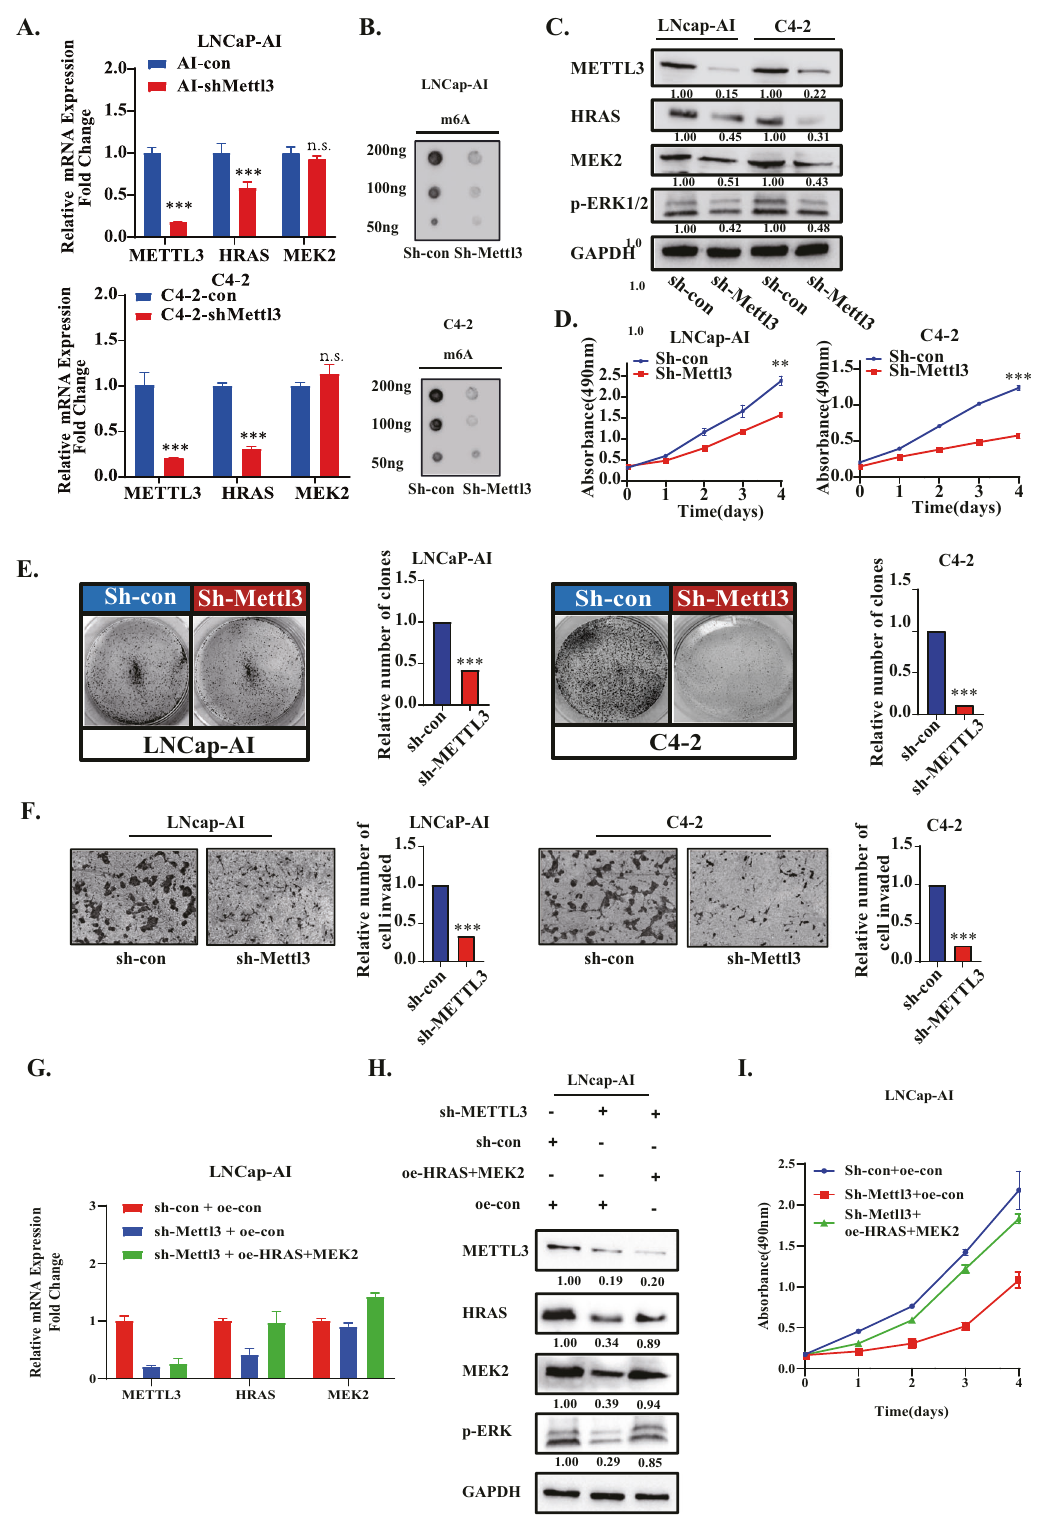
overexpressed METTL3 (oe-M3) and its catalytic mutant form (oe- M3-mut) in the LNCaP cell line. Consistent with our expectations, we found that the mRNA and protein levels of the HRAS were enhanced in oe-M3 cells but not in oe-M3-mut cells (Fig. 3A, C). Correspondingly, the protein level of the MEK2 gene but not